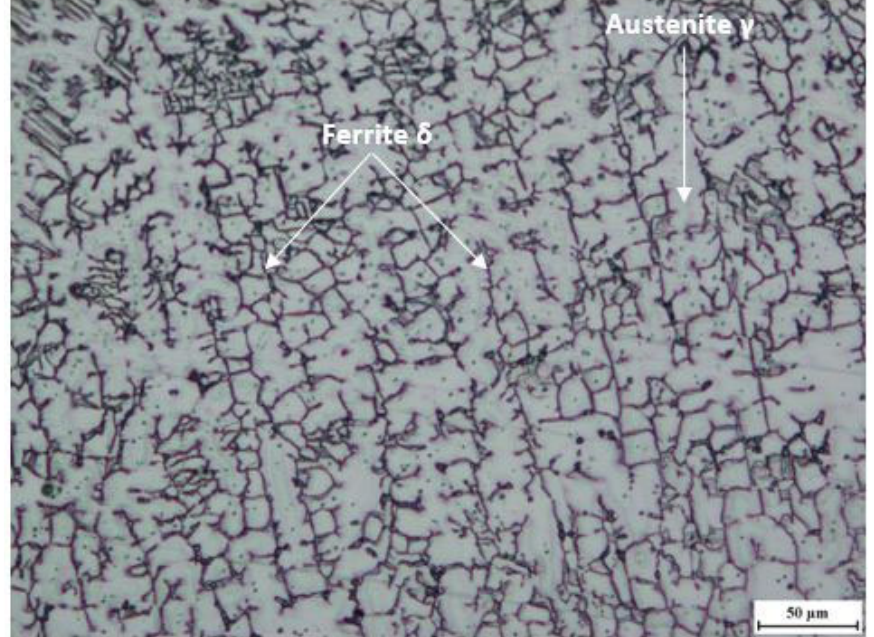
Figure 18. Optical micrograph of the weld zone (WZ) for 304 austenitic stainless steel.